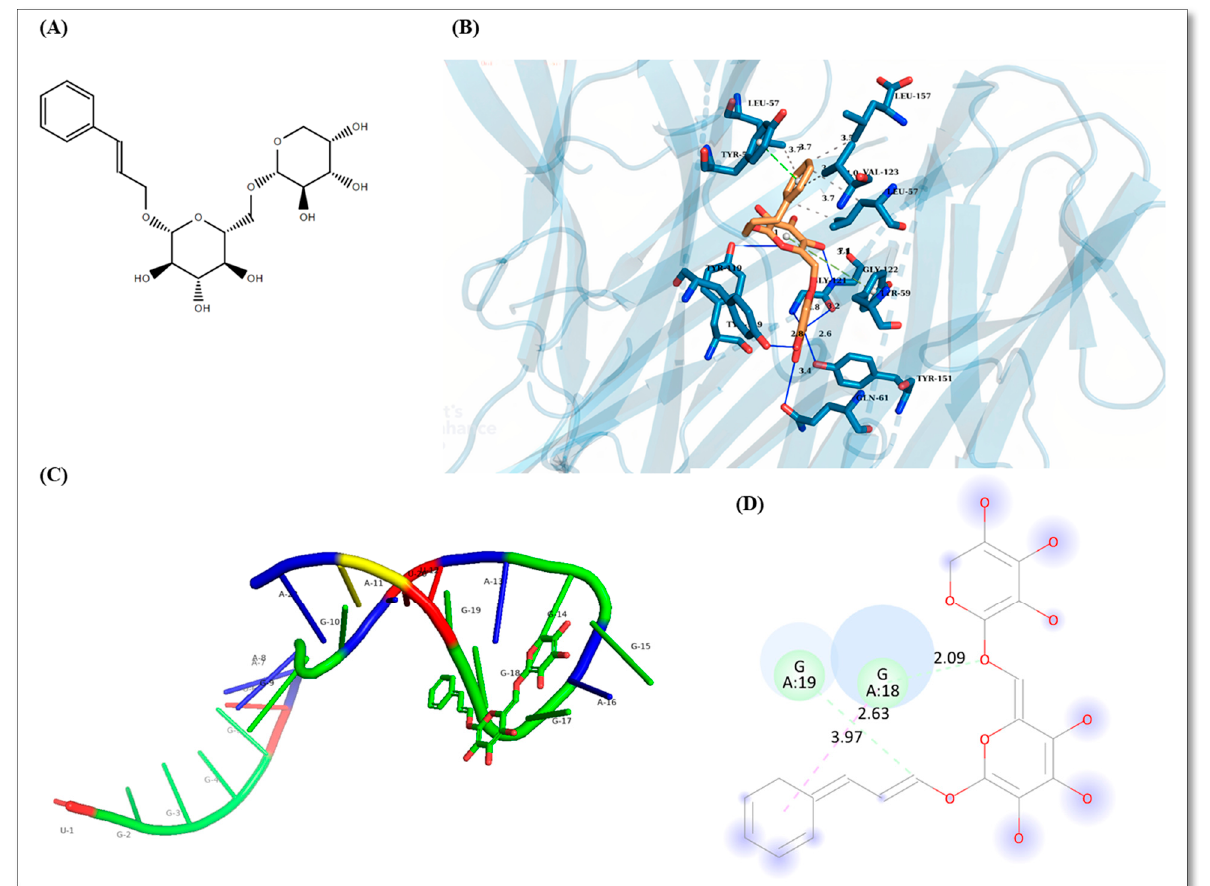
Figure 1. ( A ) Chemical structure of Rosavin. ( B ) Rosavin interaction with TNF- α with binding energy of − 11.50 kcal/mole where green dashed-lines: pi-pi stacking, blue lines: hydrogen bonds, gray dotted-lines: perpendicular pi-pi stacking. Amino acids are expressed in three-letter nomenclature and interactions lengths are computed in Angstroms. ( C ) Rosavin highest affinity pose interacting with miRNA-6881-5P . ( D ) Rosavin interaction with miRNA-6881-5P where A indicates the sequence index, A for Adenosine, G for Guanosine, lemon dashed-line for carbon hydrogen interaction, red dashed ‐ line for pi ‐ pi stacking.